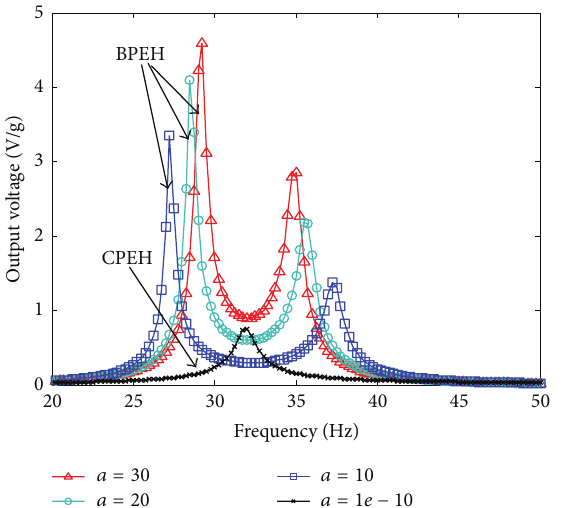
Figure 9: Output power 𝑃 0 with various 𝑞 when 𝑔 = 1 , 𝑎 = 𝑟 = 20 , and 𝑅 L = 1k Ω